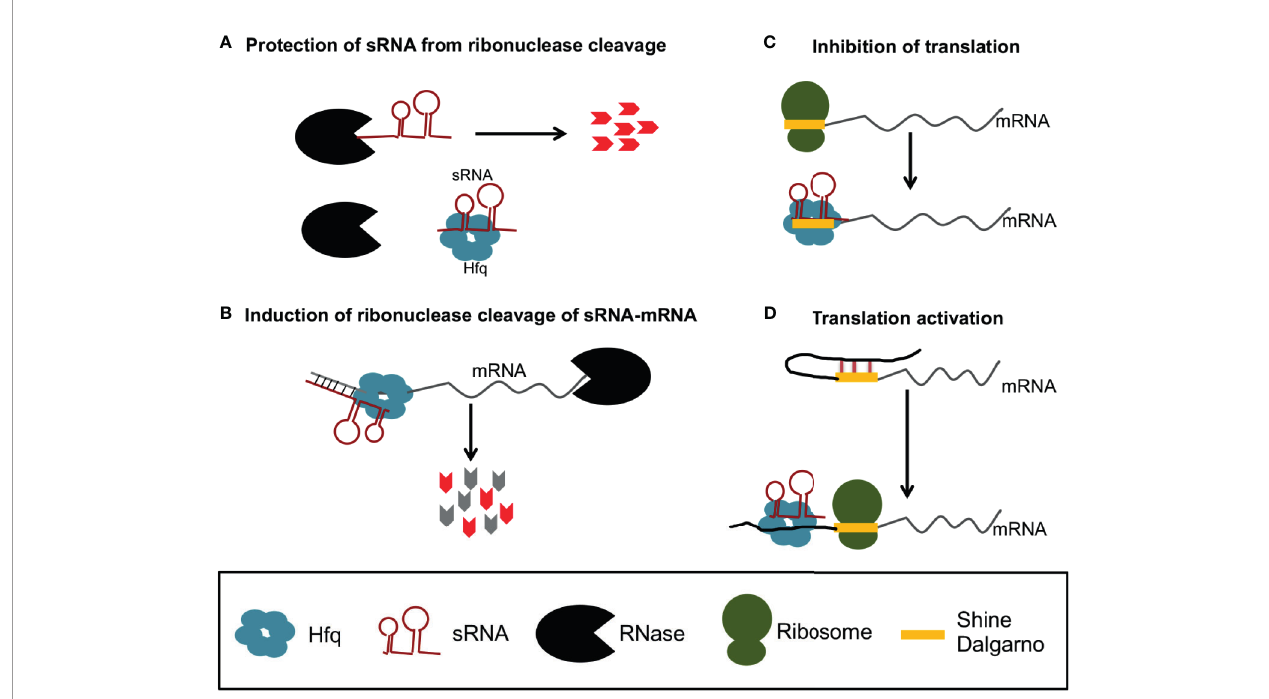
FIGURE 1 | Gene regulation by sRNA and Hfq in bacteria. Hfq can protect sRNAs from ribonuclease cleavage (A) or recruit RNases to degrade of sRNA-mRNA complexes (B) . Hfq can also promote sRNA binding that precludes access of the ribosome to the Shine Dalgarno (SD) to inhibit translation (C) , or promote sRNA binding that releases inhibitory structures to increase translation (D)